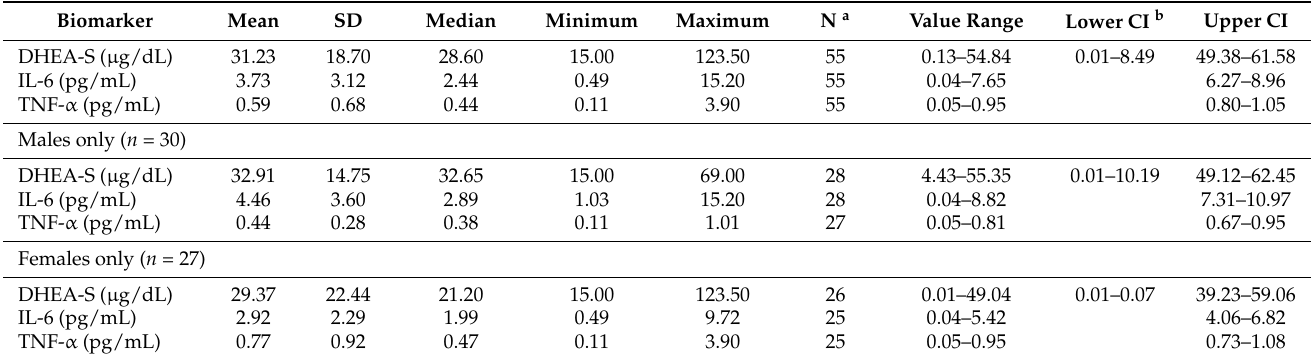
Table 1. Descriptive statistics and calculated value ranges (with 95% confidence intervals, CI) for serum biomarkers from 57 western lowland gorillas in human care.